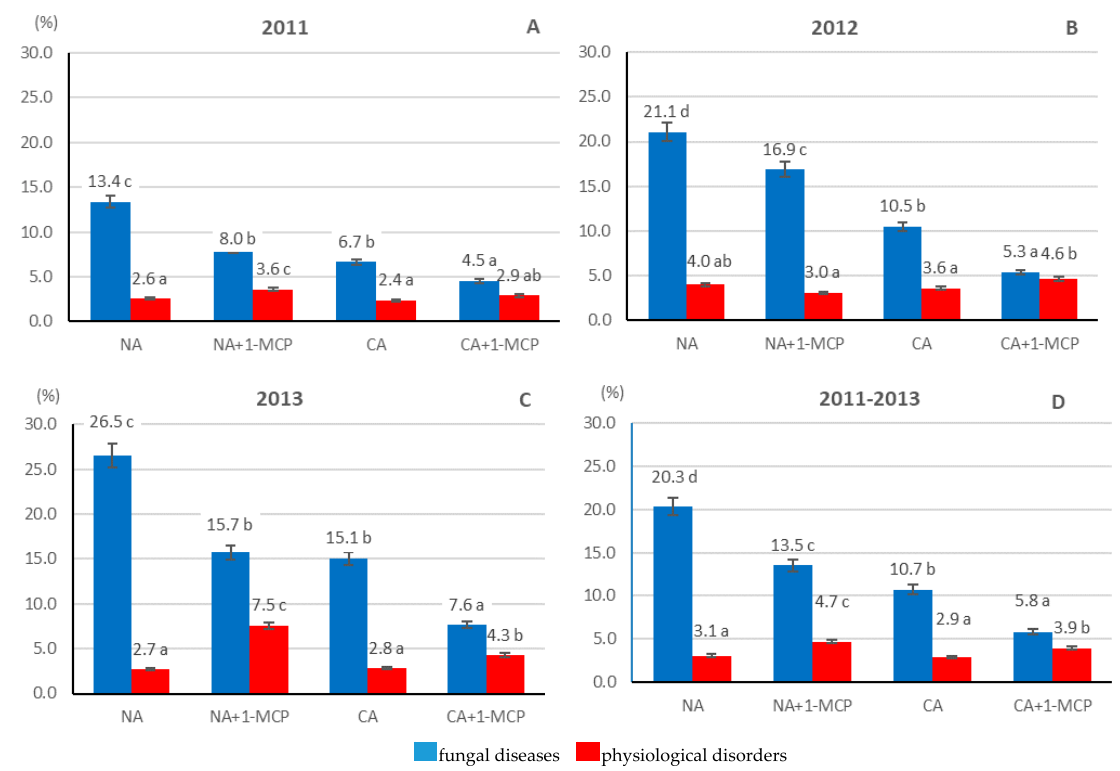
Figure 1. Total fruit losses caused by fungal diseases and physiological disorders. Numbers with different letters were significantly different at p = 0.05 according to Duncan’s test. The data are expressed as mean ± SD (n = 10). NA—normal atmosphere; NA + 1-MCP—normal atmosphere + 1-methylcyclopropene; CA—controlled atmosphere; CA + 1-MCP—controlled atmosphere + 1-methylcyclopropene.